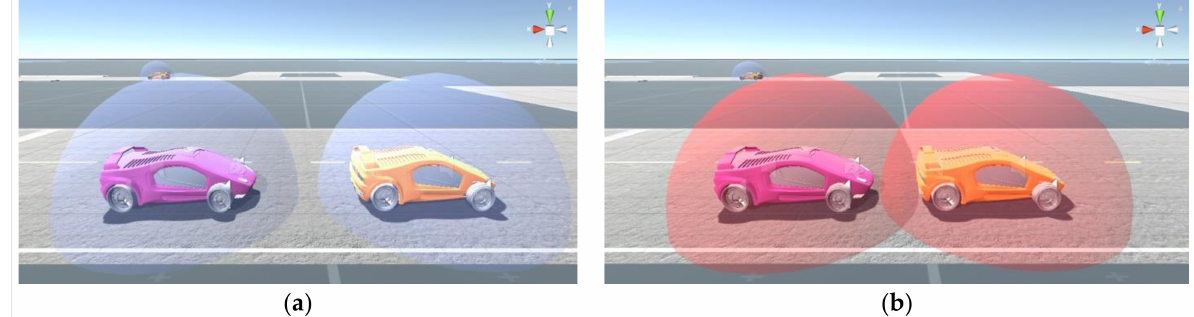
Figure 7. ( a ) Cars with “safe states”, and ( b ) cars with about-to-collide state.